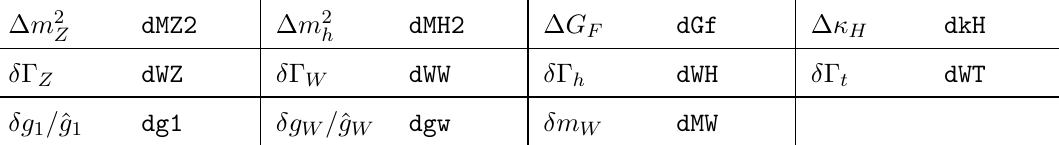
are not , C , C , C , C , C H e G H e W H e B H e WB e G e W